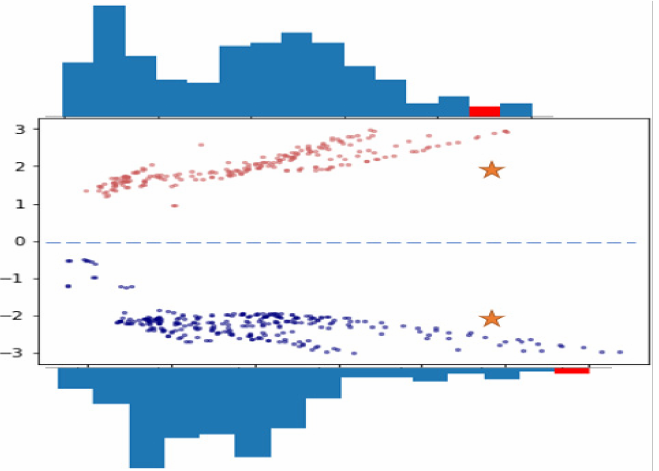
Figure 7. Frequency histograms of the x-coordinates of the left and right (tree canopy) points in {T} when the robot is near the end of the row. The red bins represent the detected row-end segment. The stars are the manually measured row endpoints. The blue dashed line is the detected row